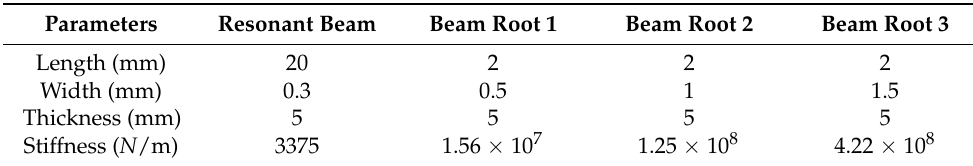
Table 2. Parameters of the resonant beam and beam